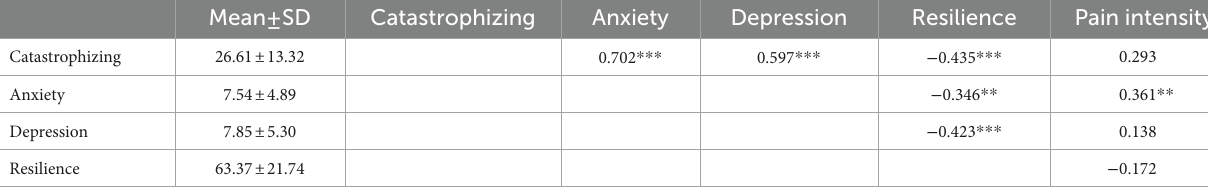
TABLE 3 Mean and SD values of the continuous variables and correlation coefficients between the continuous